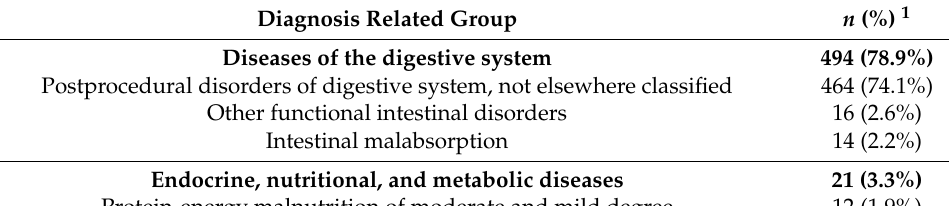
Table 3. Principal diagnoses in HPN patients by ICD-10 groups.